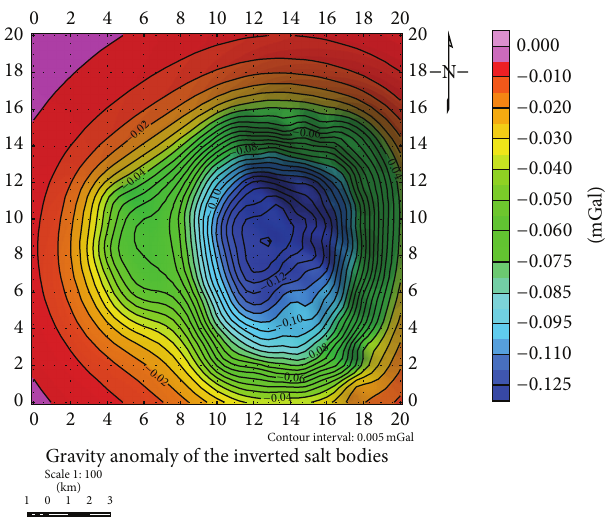
Figure 12: Gravity anomaly caused by the 3DInvM shown in Figure 11.